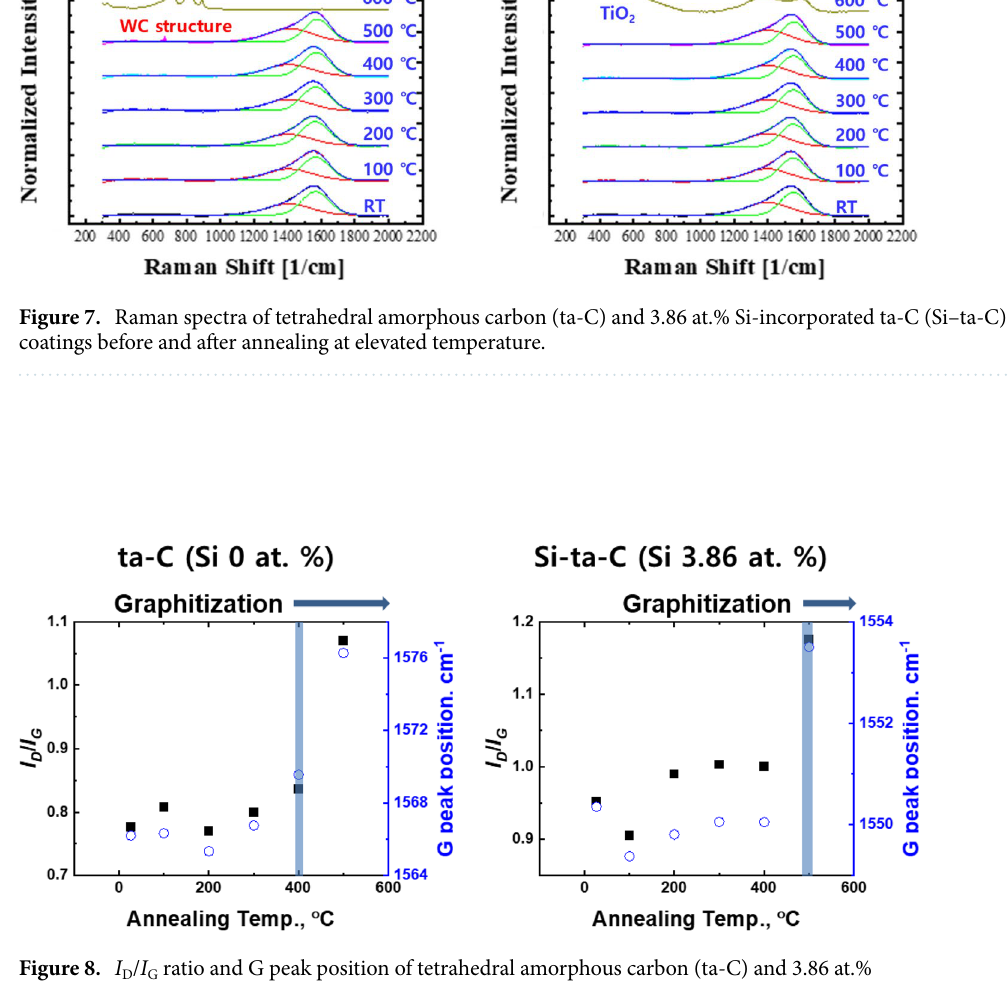
Figure 8. I D / I G ratio and G peak position of tetrahedral amorphous carbon (ta-C) and 3.86 at.% Si-incorporated ta-C (Si–ta-C) coatings before and after annealing at different temperatures (analyzed using Raman